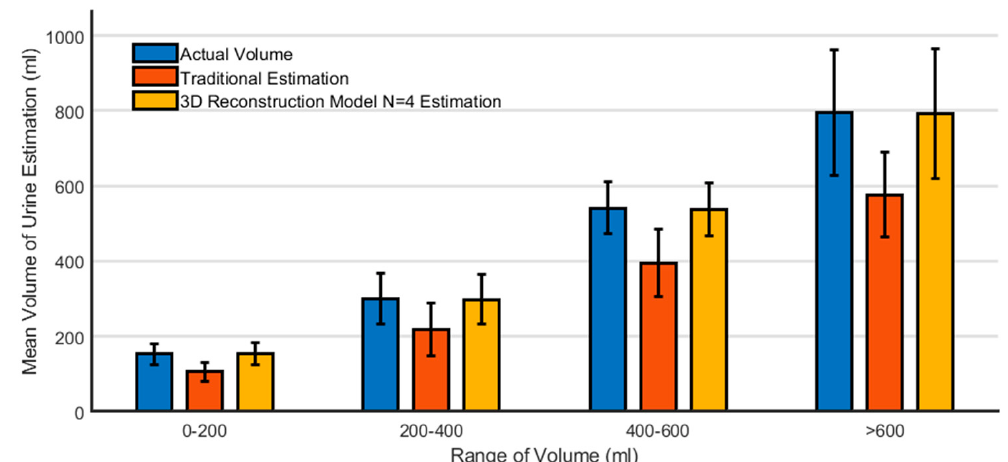
Figure 5. Actual volume compared with traditional and 3D reconstruction estimated volume in four different groups of volume (0–200, 200–400, 400–600, >600 mL).